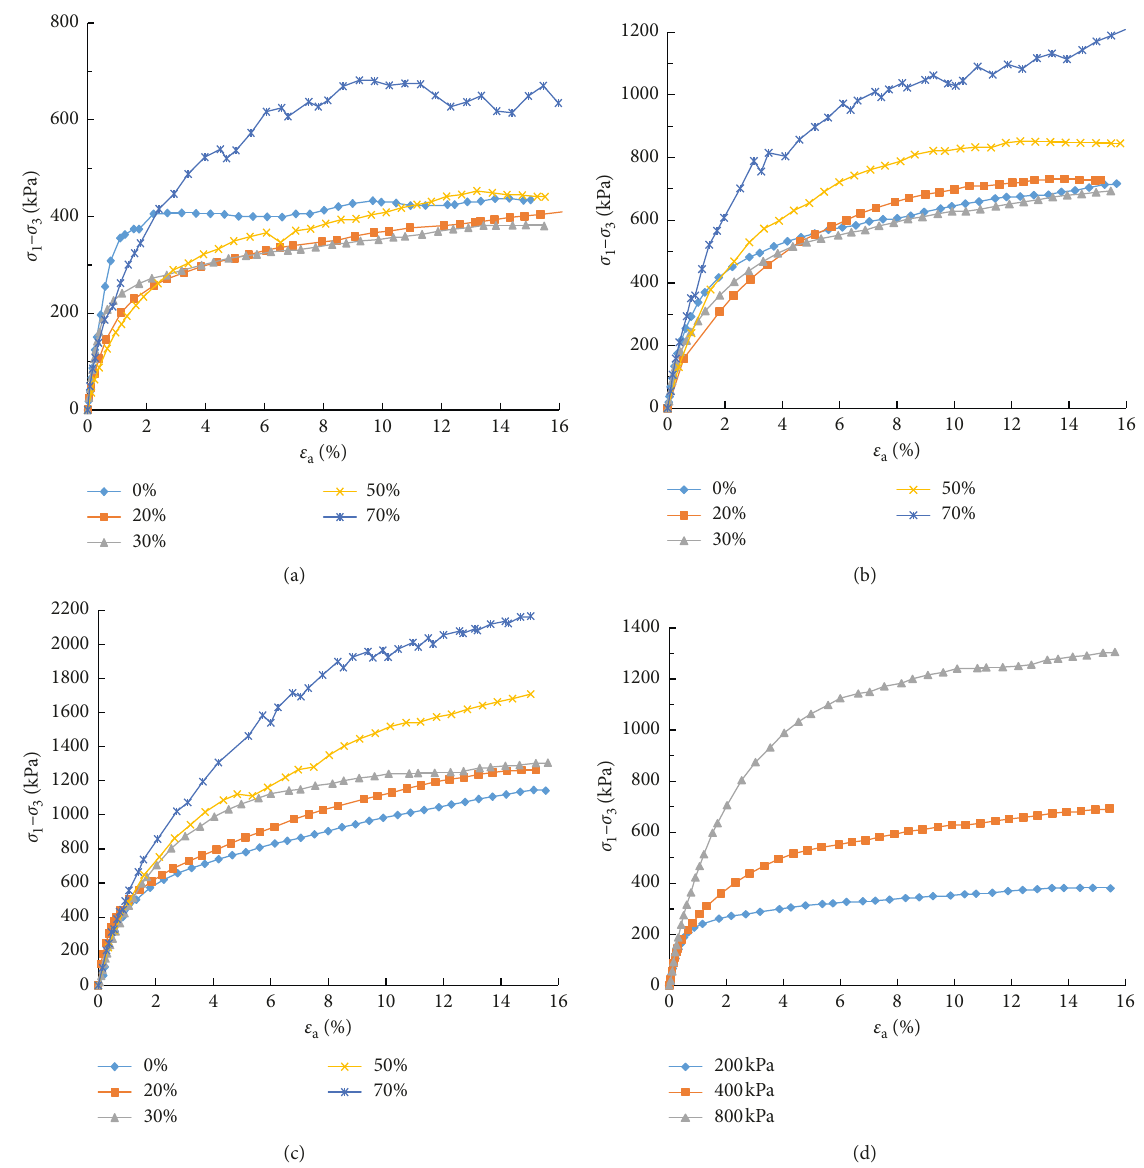
Figure 5: Curves of ( σ 1 − σ 3 ) ∼ ε under different confining pressures: (a) 200kPa confining pressure; (b) 400 kPa confining pressure; (c) 800kPa confining pressure; (d) 30% rock